Question: Summarize what this figure shows in one sentence.
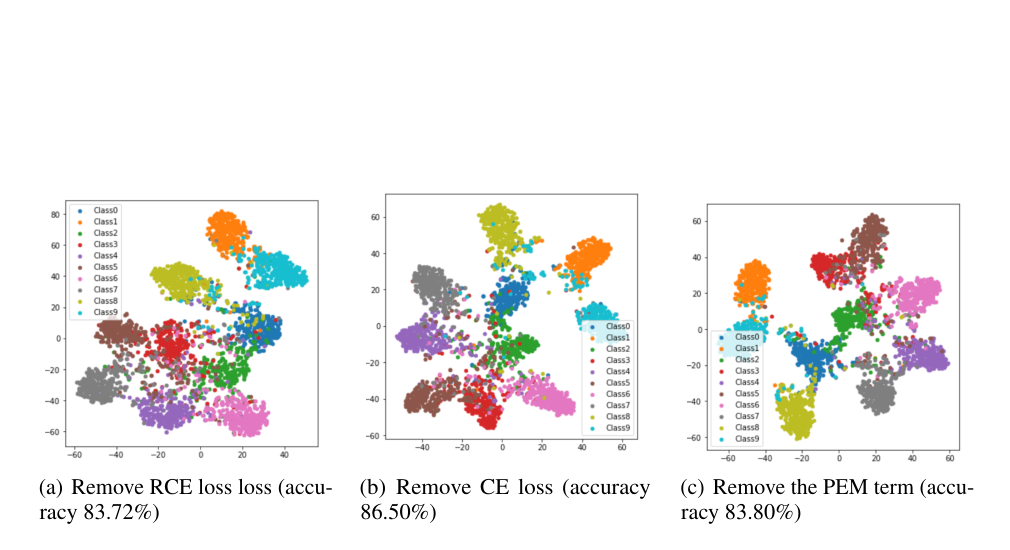
Answer: Ablation experiments with 40% symmetric noisy labels for in CIFAR-10 train dataset.All the t-SNE visualization in performed in test dataset